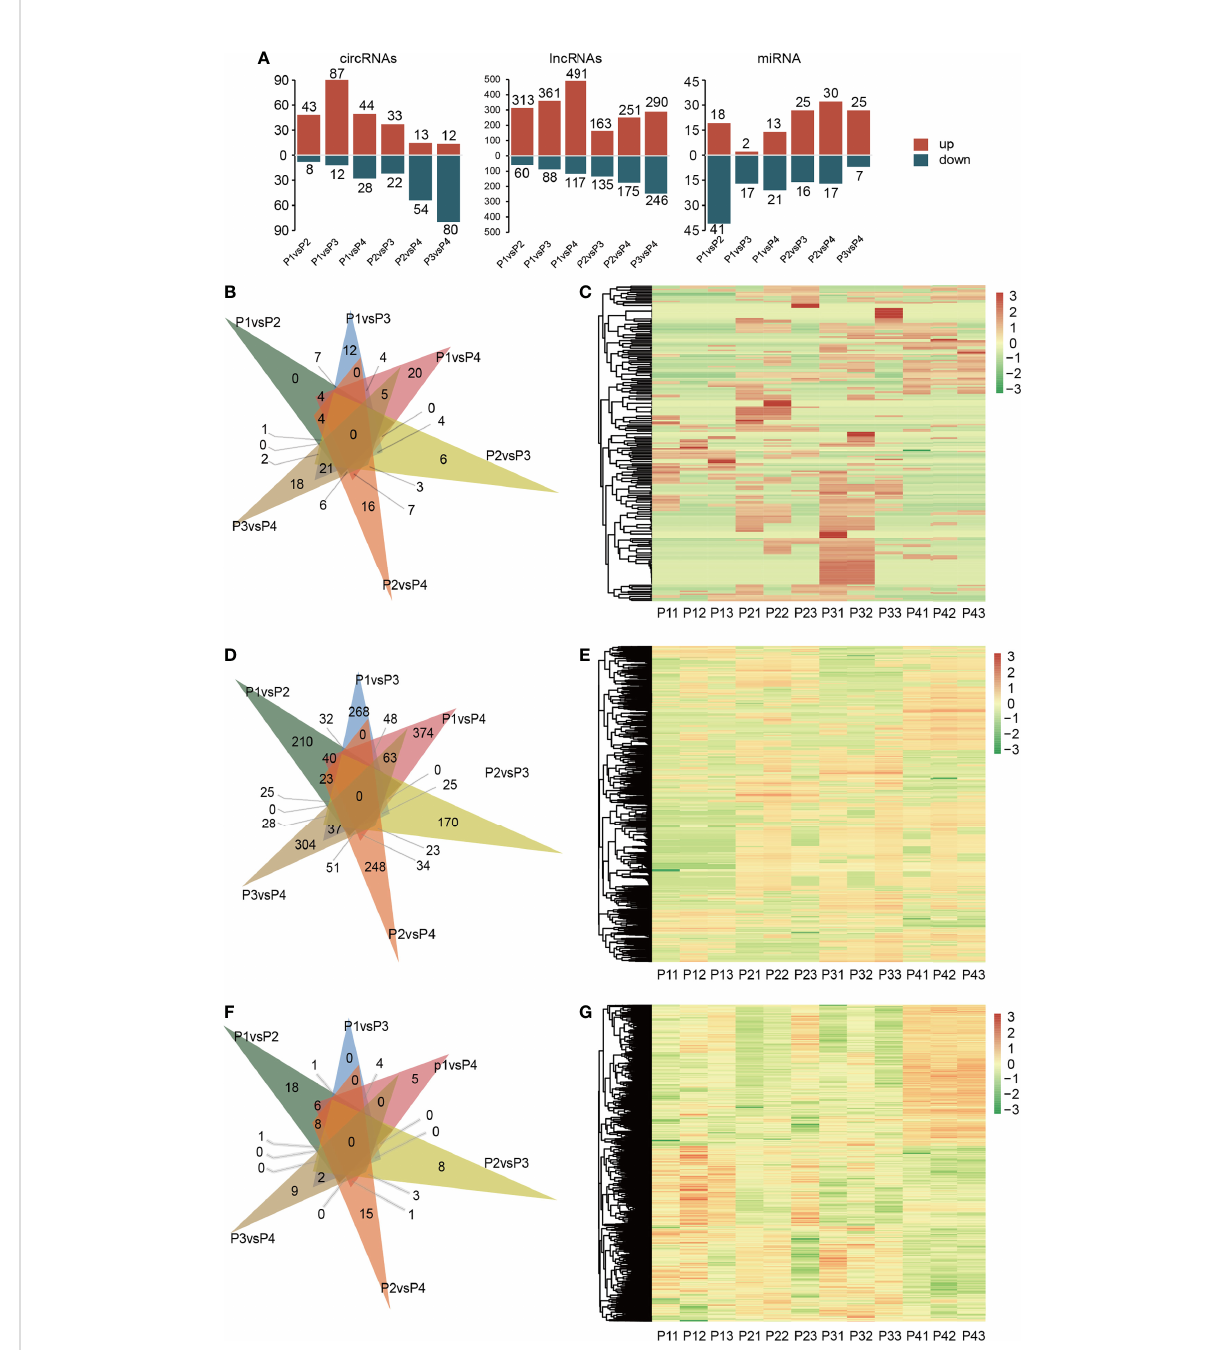
FIGURE 2 Differential expression analysis of ncRNAs in response to drought stress treatment. Drought treatment with three biological repetitions each: 0 day (P11, P12, P13), 2 days of drought treatment (P21, P22, P23), 4 days of drought treatment (P31, P32, P33) and 6 days of drought treatment (P41, P42, P43). (A) The regulation of different kinds of DERNA between each treatment. (B) Venn diagram of DE circRNAs at six group of treatment. (C) Heatmap of expression of all DE circRNAs in all samples, the horizontal coordinates in the diagram represent the sample names and the clustering results of the samples, the vertical coordinates represent the differential genes and the clustering results of the genes. Different columns in the graph represent different samples, and different rows represent different genes. The color represents the expression level of the gene in the sample log10(FPKM+0.000001). (D) Venn diagram of DE circRNAs at six group of treatment. (E) Heatmap of expression of all DE lncRNAs in all samples. (F) Venn diagram of DE miRNAs at six group of treatment. (G) Heatmap of expression of all DE miRNAs in all